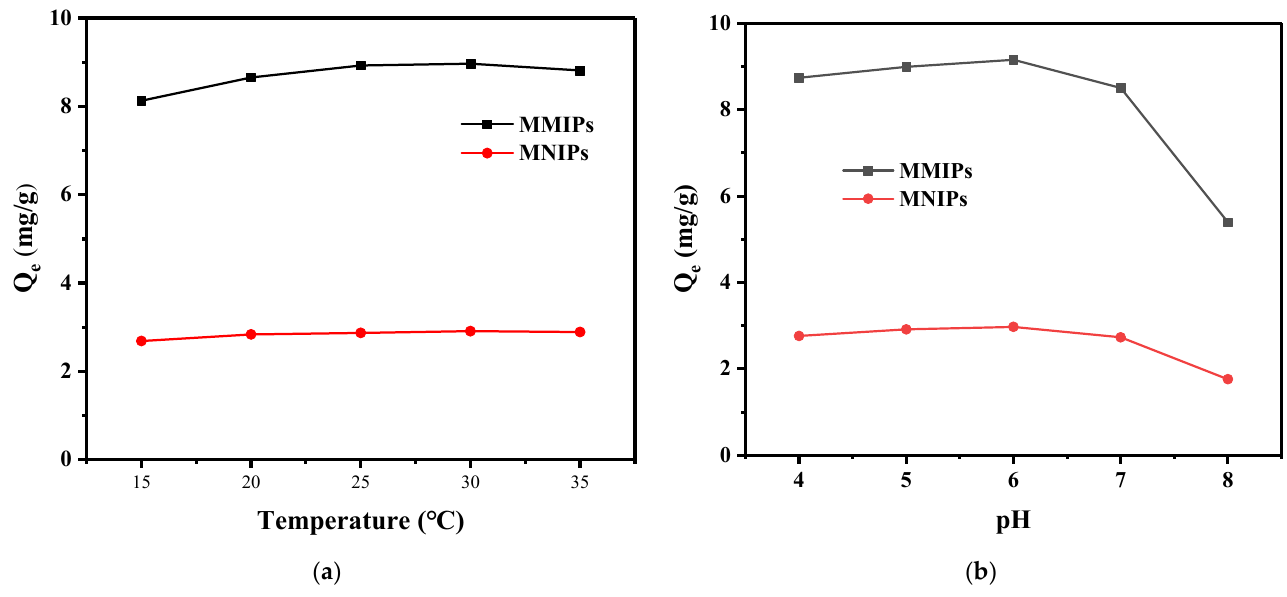
Figure 8. The effects of ( a ) temperature and ( b ) pH on adsorption process. Conditions: [E2] 0 = 5 mg/L, [MMIPs or MNIPs] 0 = 0.5 g/L, T = 30 °C, and pH = 6.0.